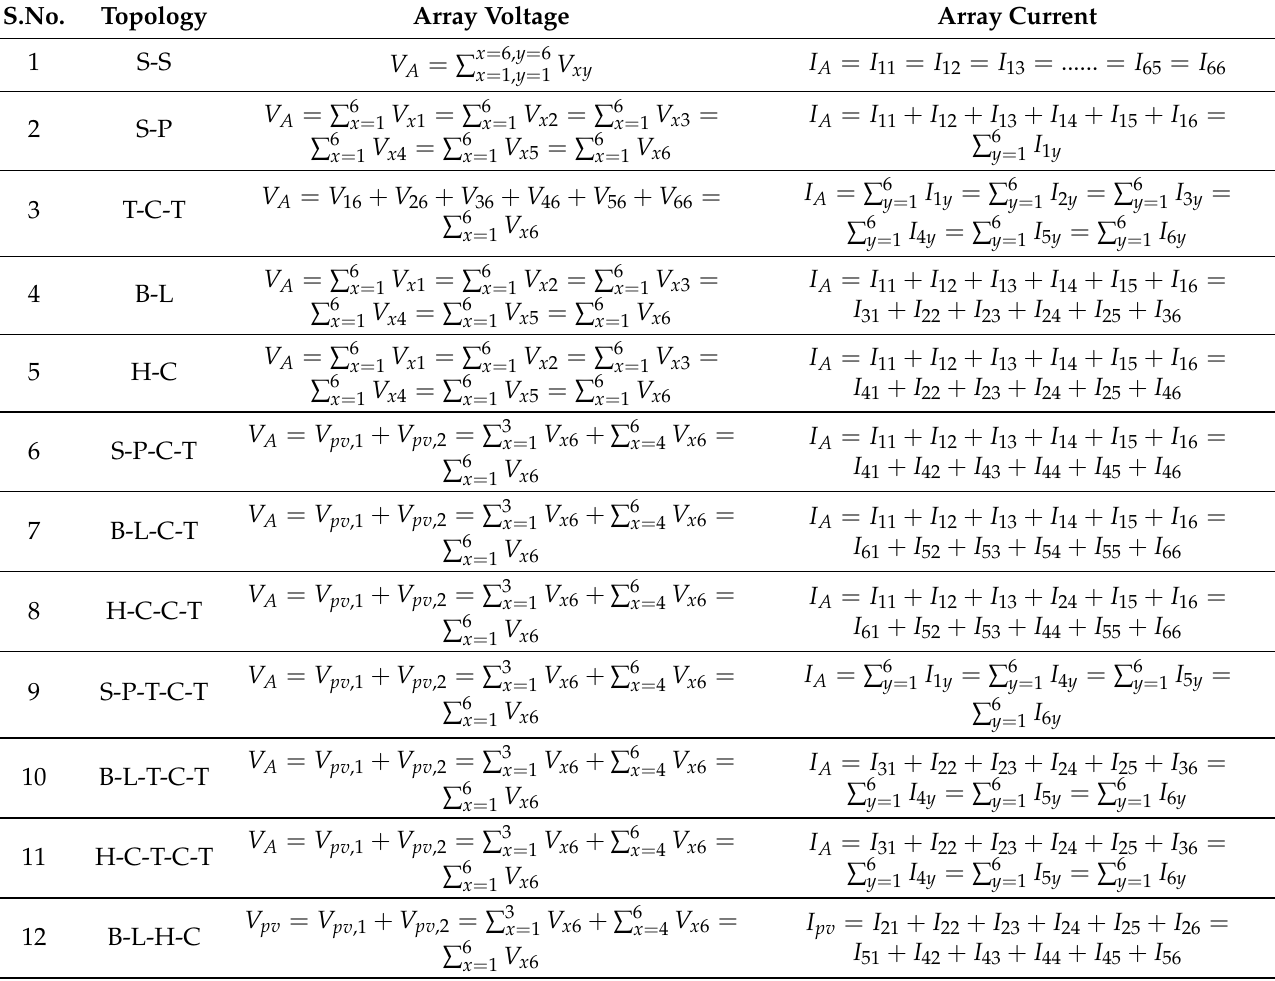
Table 1. Conventional and proposed hybrid PV array topologies output voltage and output current formulations.